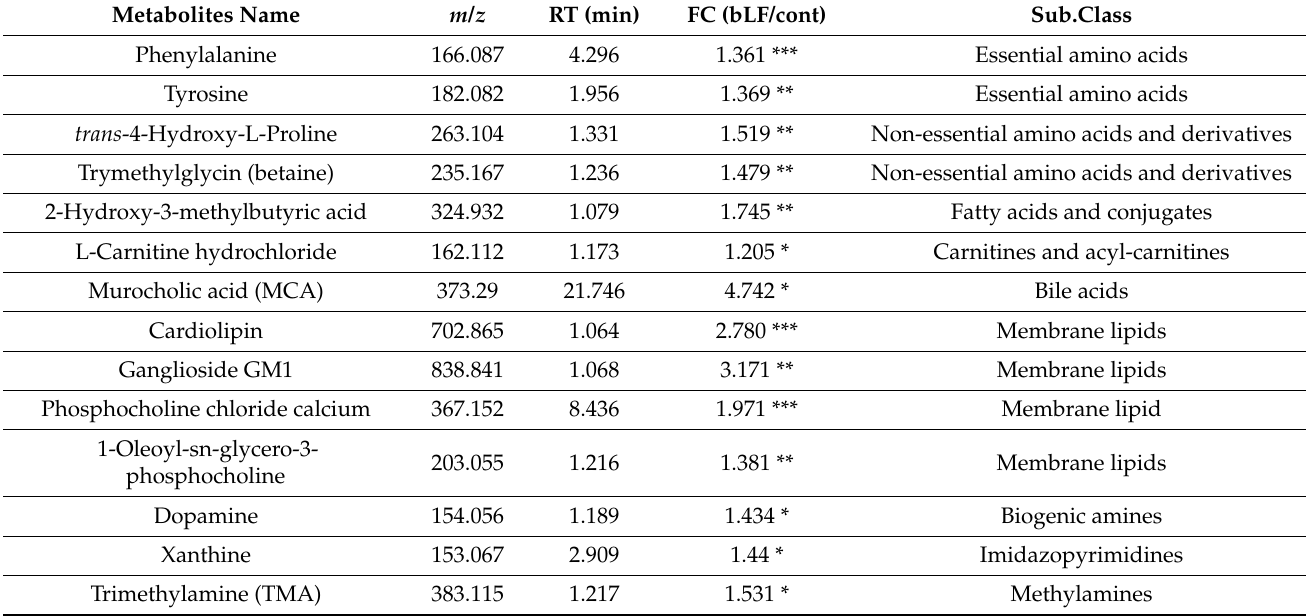
Table 8. LC-MS analysis of metabolites in plasma of pups recovered from mothers receiving the control diet or the bLF-supplemented diet. The parameters were determined at postnatal day 17. The metabolites presented in the table are those for which plasma concentrations are significantly different when comparing the control and the bLF-supplemented